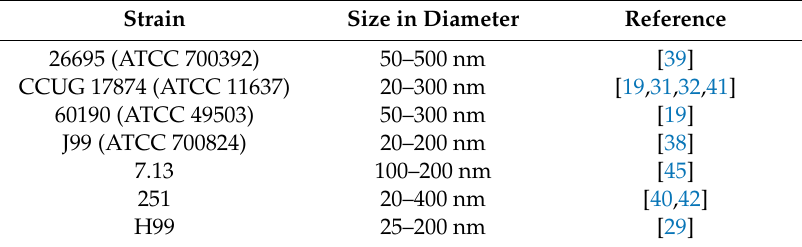
Table 1. Size of H. pylori